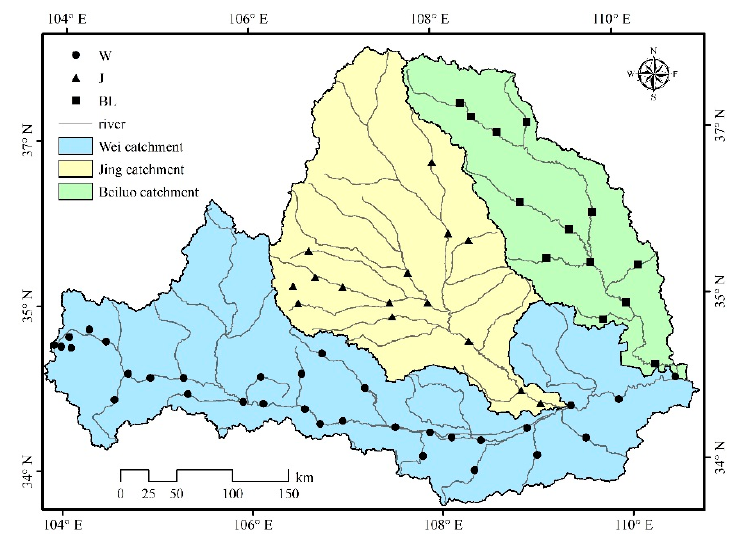
Figure 2. Sampling sites in the Wei River basin.